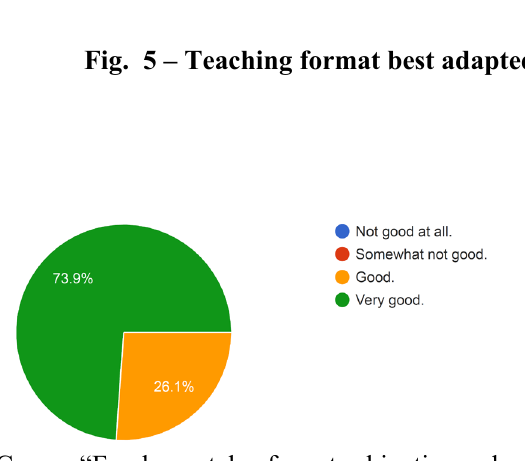
Fig. 5 – Teaching format best adapted to learning the concepts of the courses.